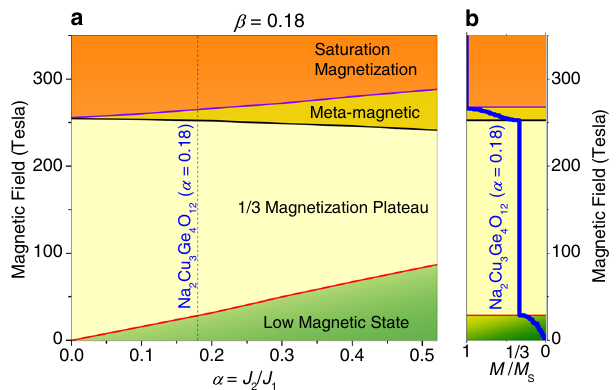
Fig. 4 | The magnetic phase diagram of Na 2 Cu 3 Ge 4 O 12 . a The evolution of the magnetic fi eld induced states as a function of the inter-trimer exchange coupling strength α = J 2 / J 1 (for β = 0.18). With the increasing α value, the 1/3 magnetization plateaustatebecomesnarrower.Theverticaldashedlinerepresentsthepositionof Na 2 Cu 3 Ge 4 O 12 . b The solid blue curve is the calculated magnetization curve for Na 2 Cu 3 Ge 4 O 12 having α =0.18[Fig.1d]illustratingthedifferentmagneticstates,i.e., low magnetic state for M / M s <1/3, 1/3 magnetization plateau for M / M s = 1/3, meta- magnetic state for 1/3< M / M s <1 and saturation magnetization for M / M s